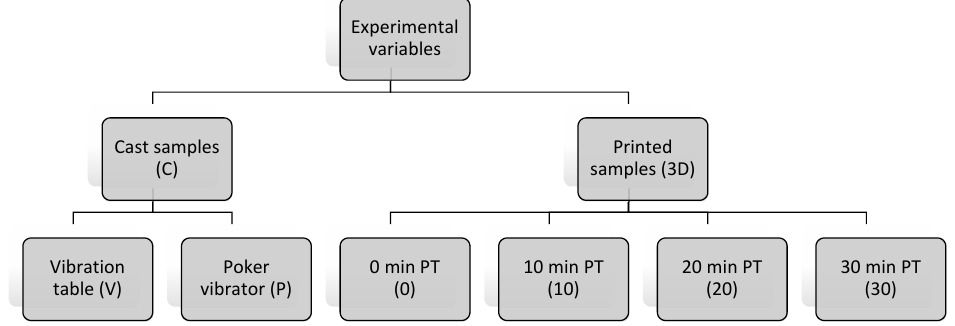
Figure 1. Experimental variables.